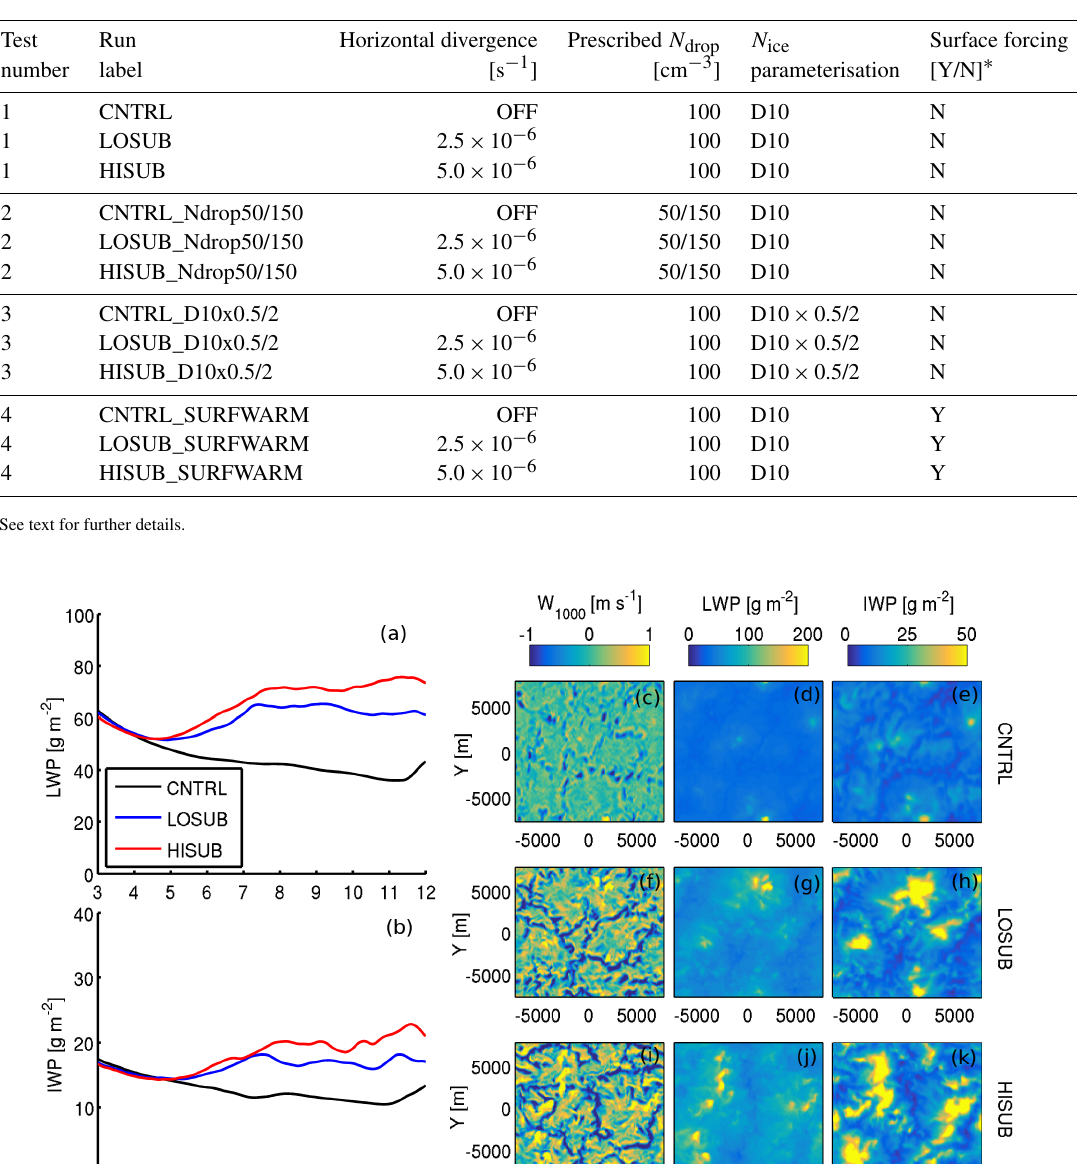
Table 1. Simulation list.